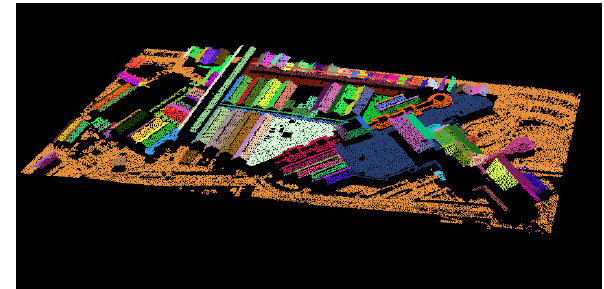
Figure 10 Manually segmented point cloud of part of the Cape Town harbour.